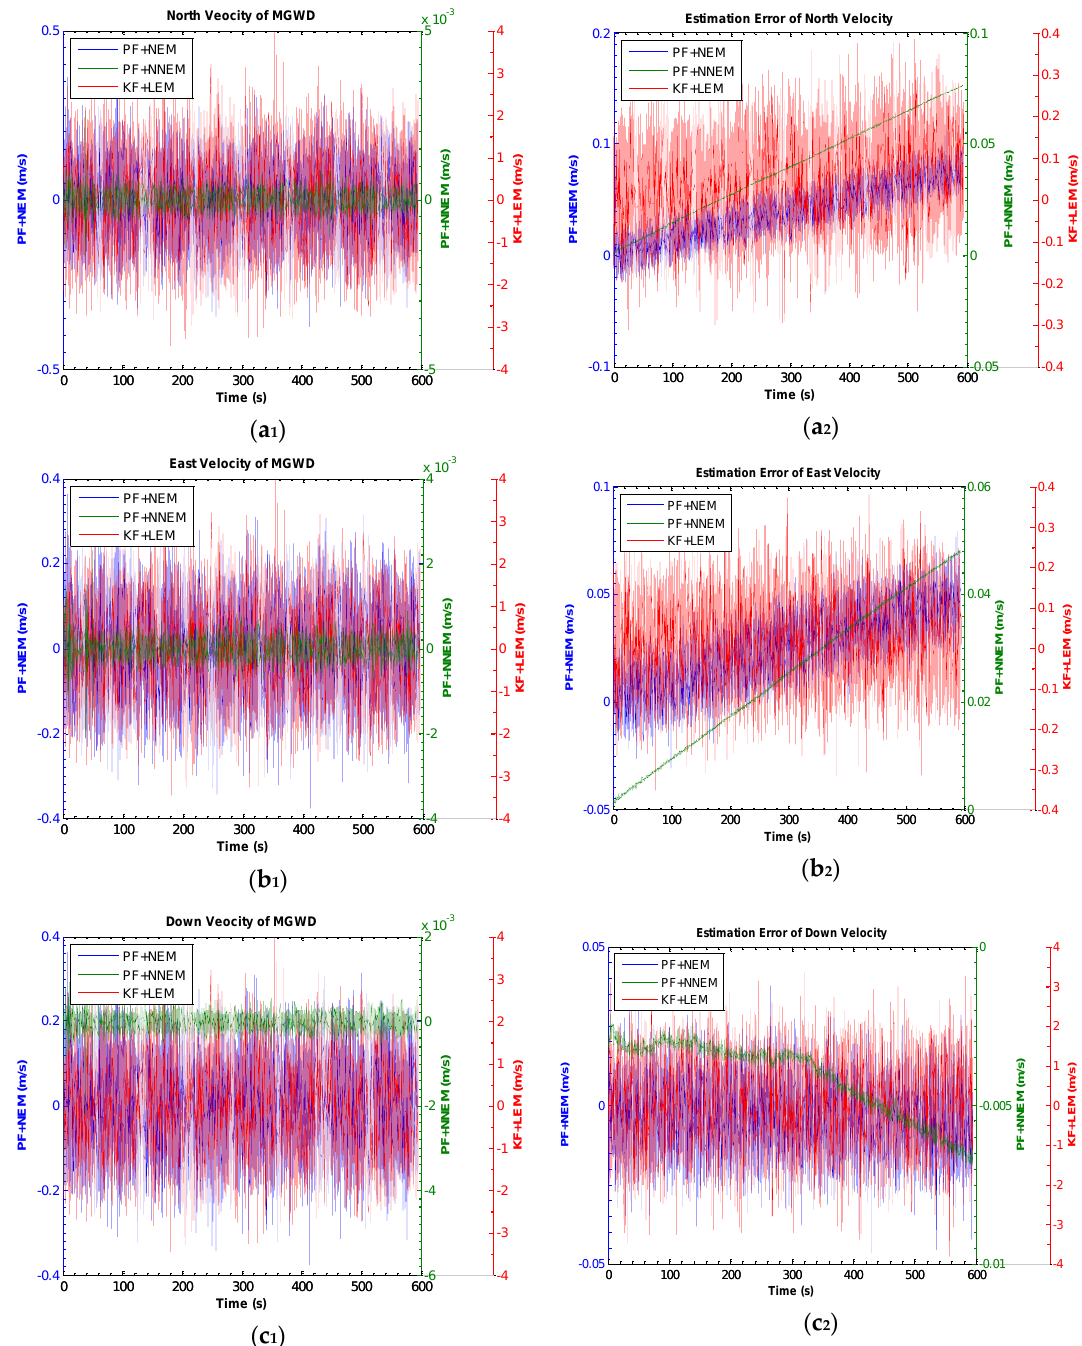
Figure 11. Results of estimation of velocity and estimation error of velocity by KF with LEM, PF with NEM, and PF with NNEM under large-angle attitude error conditions. ( a 1 ) and ( a 2 ) are the estimation of north velocity and estimation error of north velocity; ( b 1 ) and ( b 2 ) are the estimation of east velocity and estimation error of east velocity; ( c 1 ) and ( c 2 ) are the estimation of down velocity and estimation error of down velocity.